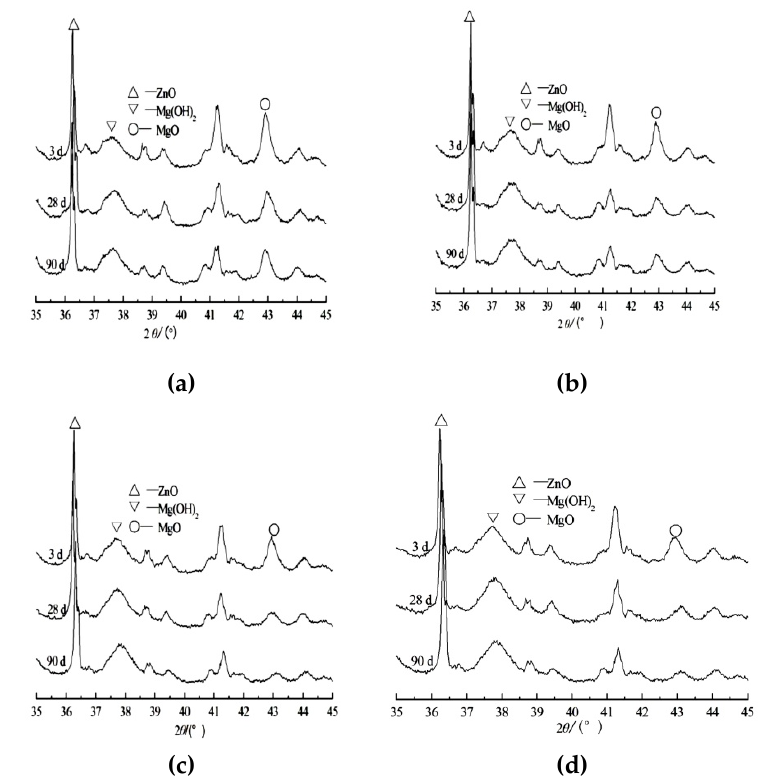
Figure 6. XRD pattern of hydration slurry mixed with MgO (65s) at different temperatures: ( a ) 20°C; ( b ) 38 °C; ( c ) 60 °C; ( d ) 80 °C.